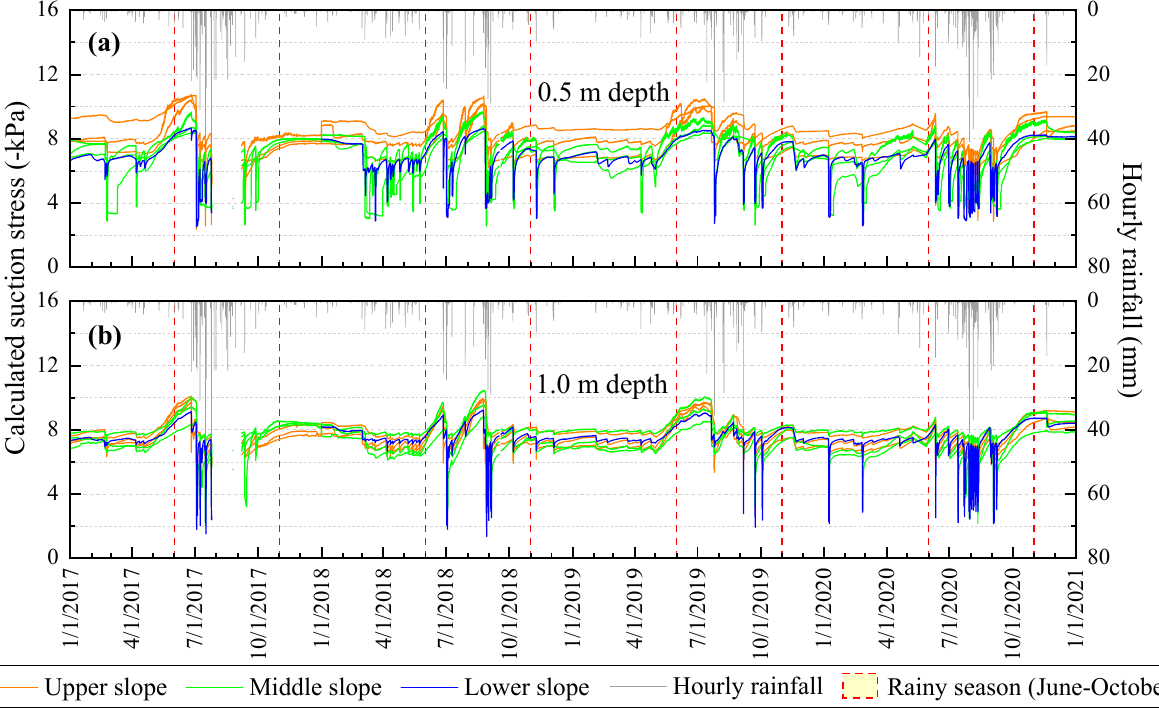
Figure 10. Four-year variations in suction stresses estimated in ( a ) 0.5 m and ( b ) 1.0 m soil depths at each of the three sections in the Songnisan landslide monitoring station.